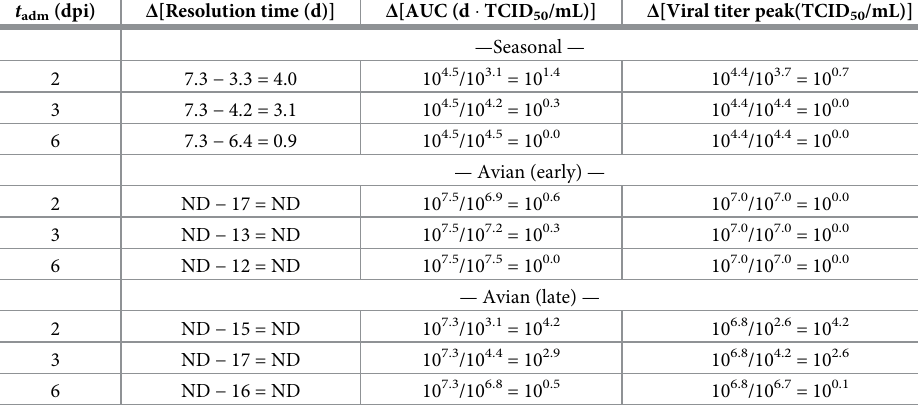
� For NAI therapy administered at various times post infection ( t adm ), the change ( Δ ) in 3 commonly reported endpoints are shown for the viral titer curves in Fig 12. The change in resolution time is computed as a difference ( Δ = without − with), whereas that for the area under the viral titer curve (AUC) and viral titer peak corresponds to the fold-change ( Δ = without/with). ND stands for not determined in cases where infection resolution ( V ( t ) < 1 TCID 50 / mL) was not achieved without